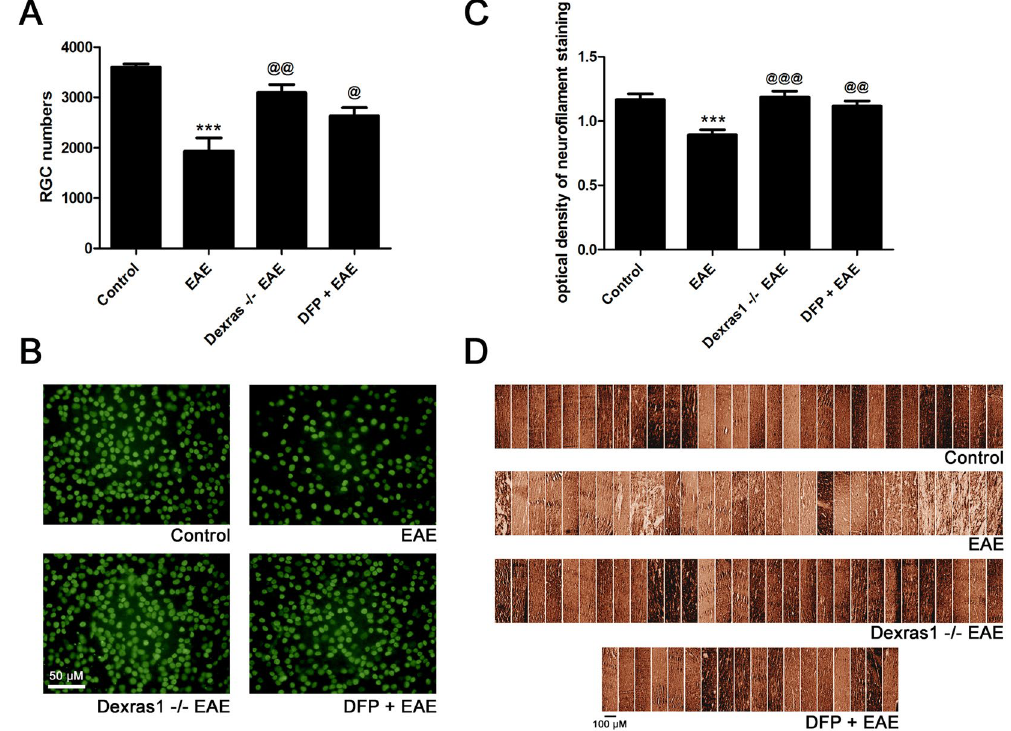
Figure 4. Dexras1 deletion or iron chelation preserves RGC numbers in the retina and prevents axonal loss in the optic nerves of EAE mice. Neuroprotective effects of Dexras1 deletion or iron chelation were evaluated by counting RGCs in the retina and quantifying axonal staining density in the optic nerve. RGCs were immunolabeled with Brn3a antibody and counted in a standardized, masked fashion. ( A ) RGC loss in eyes of EAE mice ( *** p < 0.001 versus control, N = 5 right eyes of 5 mice) is reduced in Dexras1 KO EAE mice ( @@ p < 0.01 versus EAE, N = 5 eyes of 5 mice). Daily treatment with iron chelator DFP (1 mg/mL, N = 4 eyes of 4 mice) leads to significant ( @ p < 0.05 versus EAE) improvement in RGC numbers. ( B ) Representative images show RGCs in one field of retina from each group (original magnification × 20). ( C ) Neurofilament staining was used to evaluate axonal loss in sections of optic nerves isolated at day 42 post immunization. The optical density of neurofilament staining, calculated by a masked investigator using the average of three equal-sized fields from each optic nerve, shows a significant decrease ( *** p < 0.001) in optic nerves (N = 10 nerves) from EAE